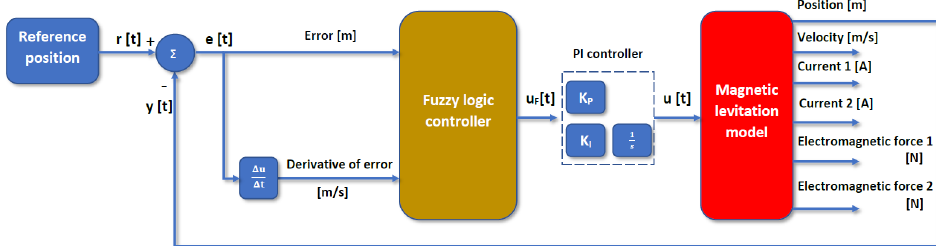
Figure 4. Diagram of magnetic levitation system involving a hybrid fuzzy logic PID